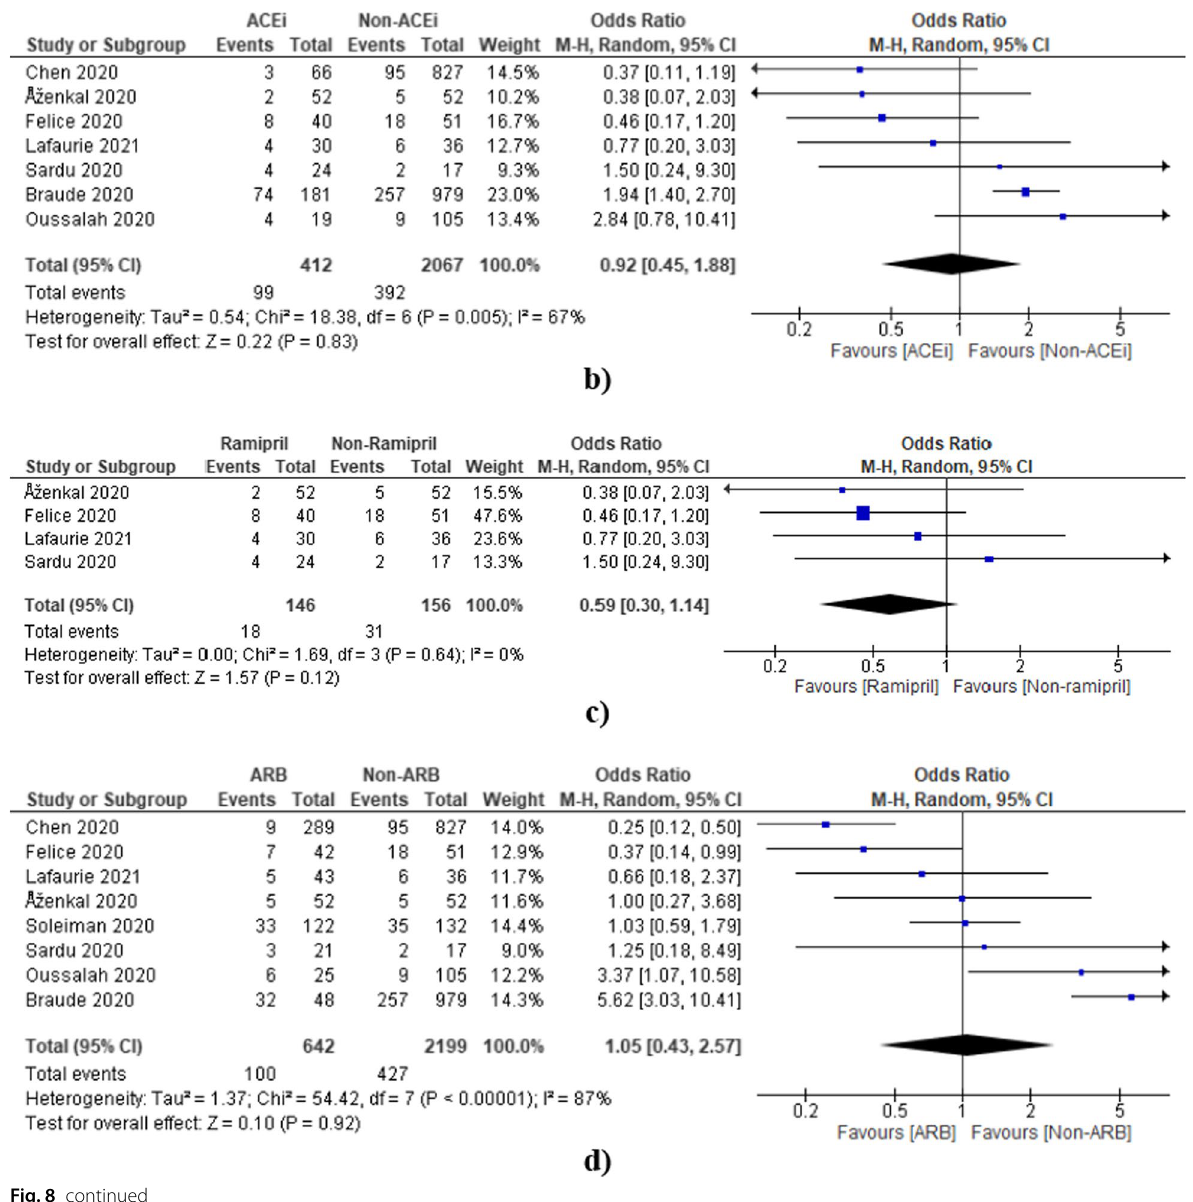
data to check the effect of all individual ACEi/ARBs on the outcome. The studies published in the English language are only considered. The search is limited to selected databases only. The funnel plots have also indi- cated the involvement of publication